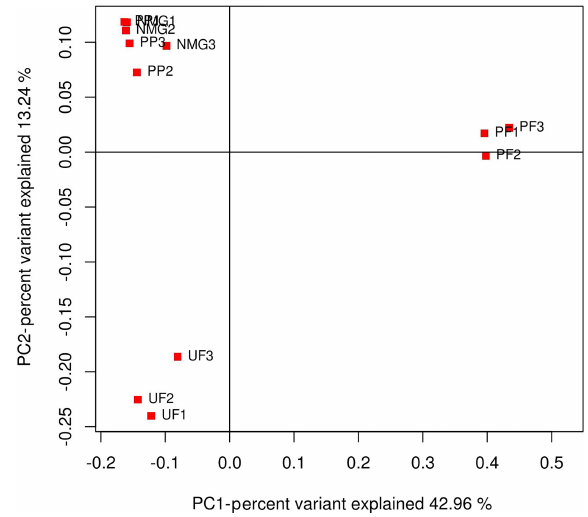
Figure 1. Ordination plot showing the grouping of soil bacterial communities according to PCoA based on Bray–Curtis distance ma- trix. NMG: native meadow grassland; UF: 50-year upland field; PF: 26-year paddy field; PP: 34-year poplar